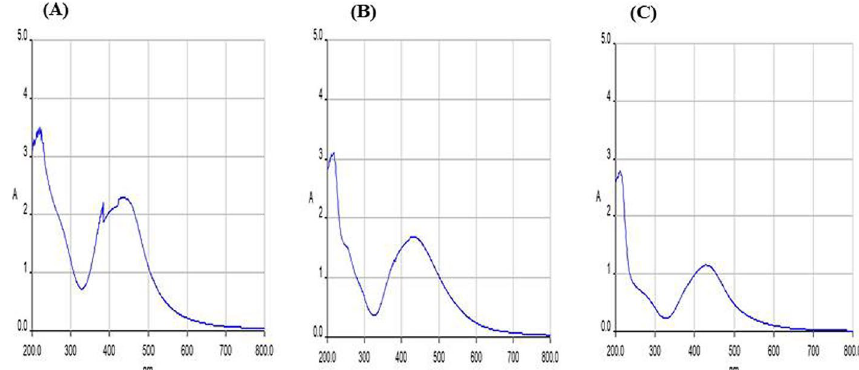
Fig. 3 The graph obtained from the UV–Vis spectra of greener AgNPs formed from aqueous solution of AgNO 3 with Polygonum plebeium leaf extract in different ratios- A ) Poly 1:2, B ) Poly 1:4 & C ) Poly